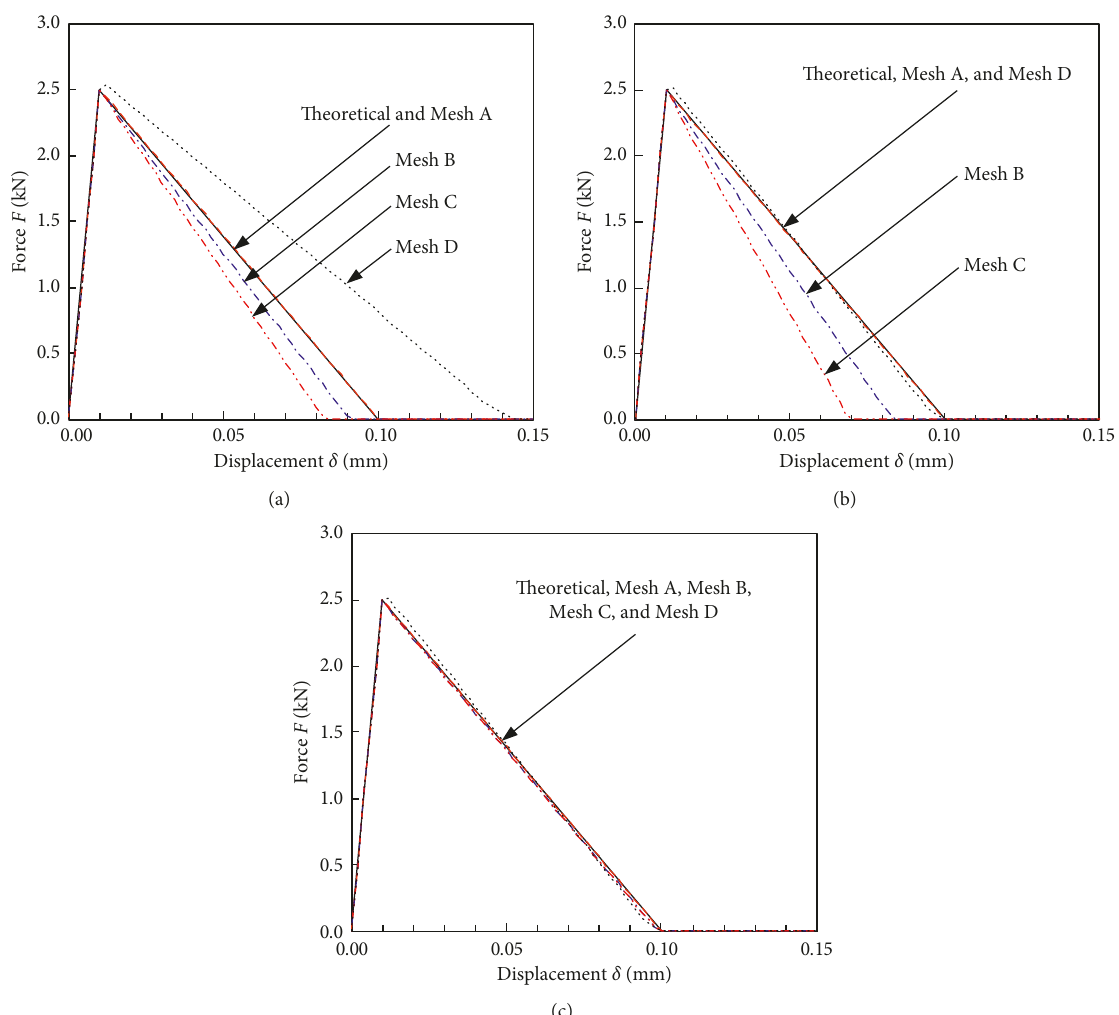
Figure 13: Force-displacement responses obtained by different estimations of crack bandwidth with different mesh irregularities: crack bandwidth estimated by (a)